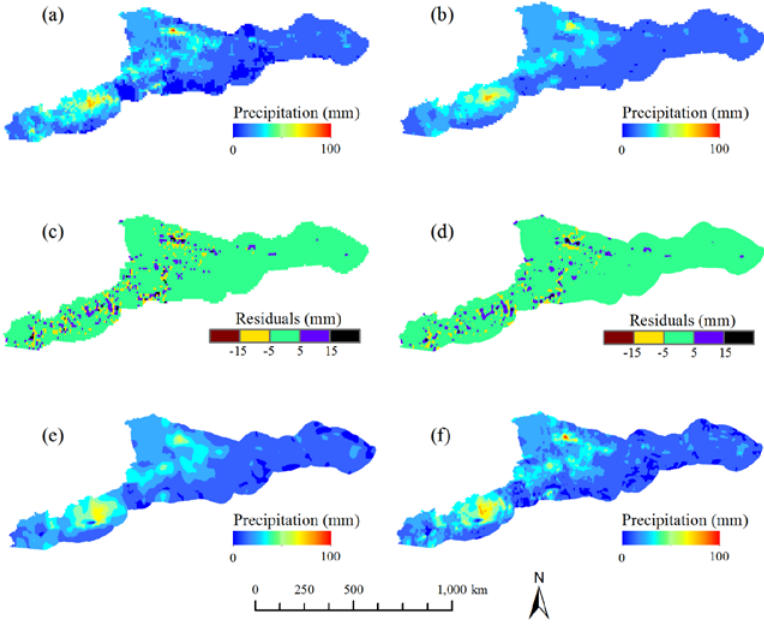
Figure 14. Comparison of the DS_CIMERG product in September 2017 before and after residual correction. ( a ) CIMERG; ( b ) predicted precipitation (10 km); ( c ) residuals (10 km); ( d ) residuals (1 km); ( e ) DS_CIMERG; ( f ) downscaled precipitation after residual correction.